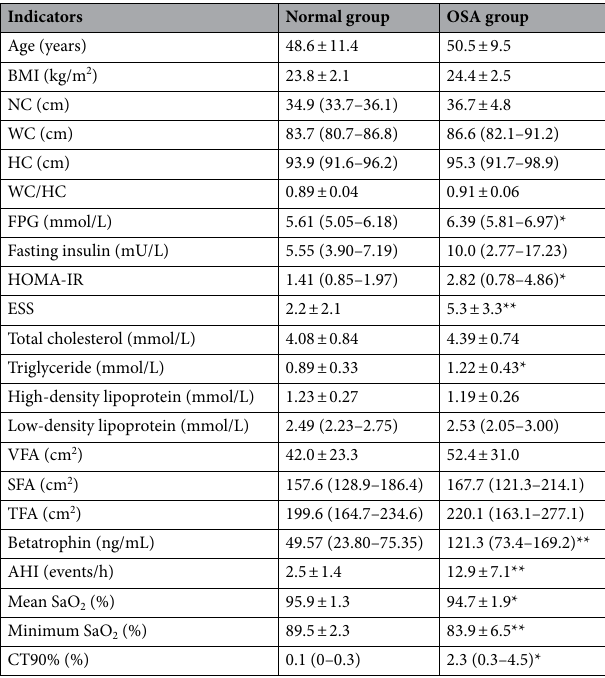
Table 2. Differences between normal group and OSA group after bariatric surgery. Data are expressed as the mean ± SD or mean with 95% confidence interval. OSA obstructive sleep apnea, BMI body mass index,